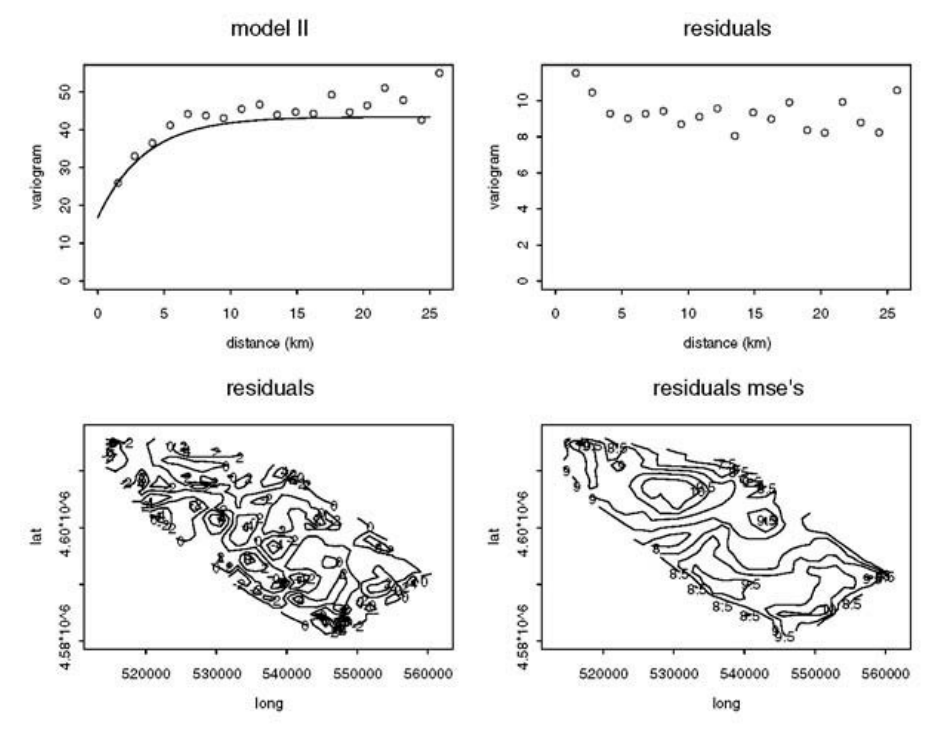
Figure 4 – Empirical and estimated spherical variogram for model II, empirical variogram of residuals, contourplot (based on a linear interpolation) of residuals and their mse’s.